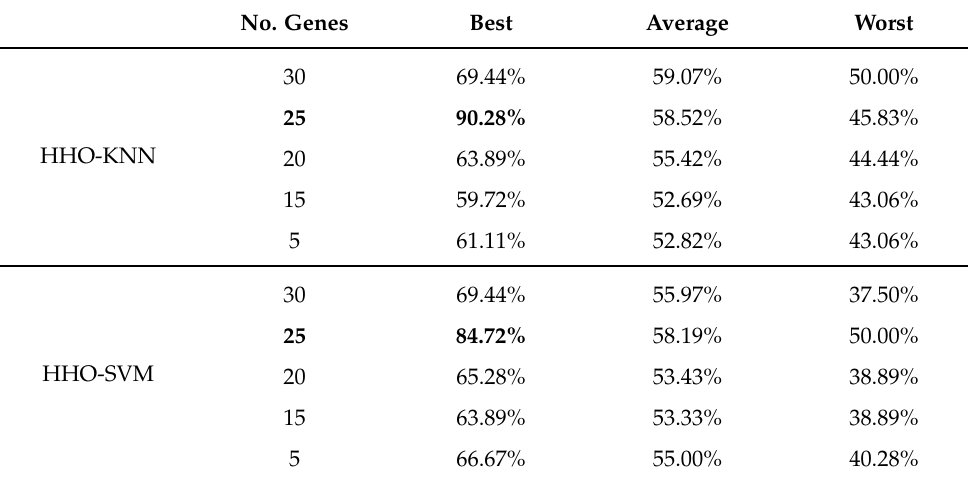
Table 5. Leukemia3 data set results.